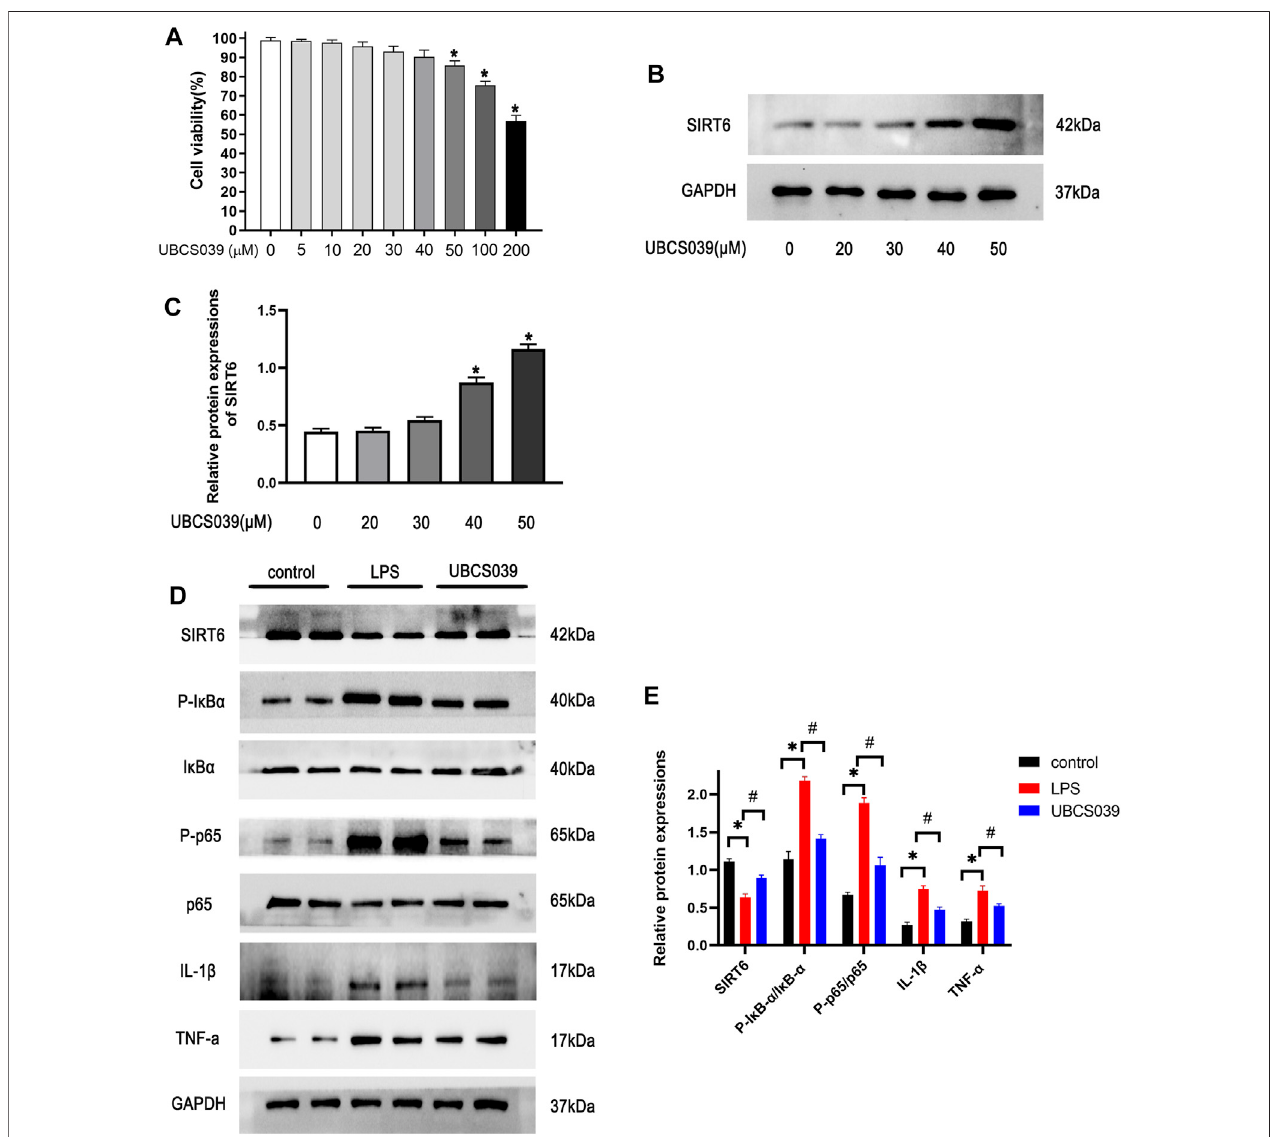
FIGURE 6 | Effects of UBCS039 on the NF- κ B pathway in LPS-induced RAW264.7 macrophages. (A) Toxic different doses of UBCS039 were by CCK-8 assay. (B) RAW 264.7cells wereexposedtoUBCS039(0, 20,30,40, and 50 μ M) for24 h;WesternblotanalysisofSIRT6 levels. (C) Densitometric analysisofSIRT6. (D) After pretreatmentwith40 μ MUBCS039for2 h,cellswereaddedwith10 μ g/mlLPSfor24 h.TherelativeproteinsweredetectedbyWesternblot. (E) Densitometricanalysis of these proteins. * p < 0.05, compared with the control group. # p < 0.05, compared with the model group. n = 3 per group. Data are represented as mean ± SD.